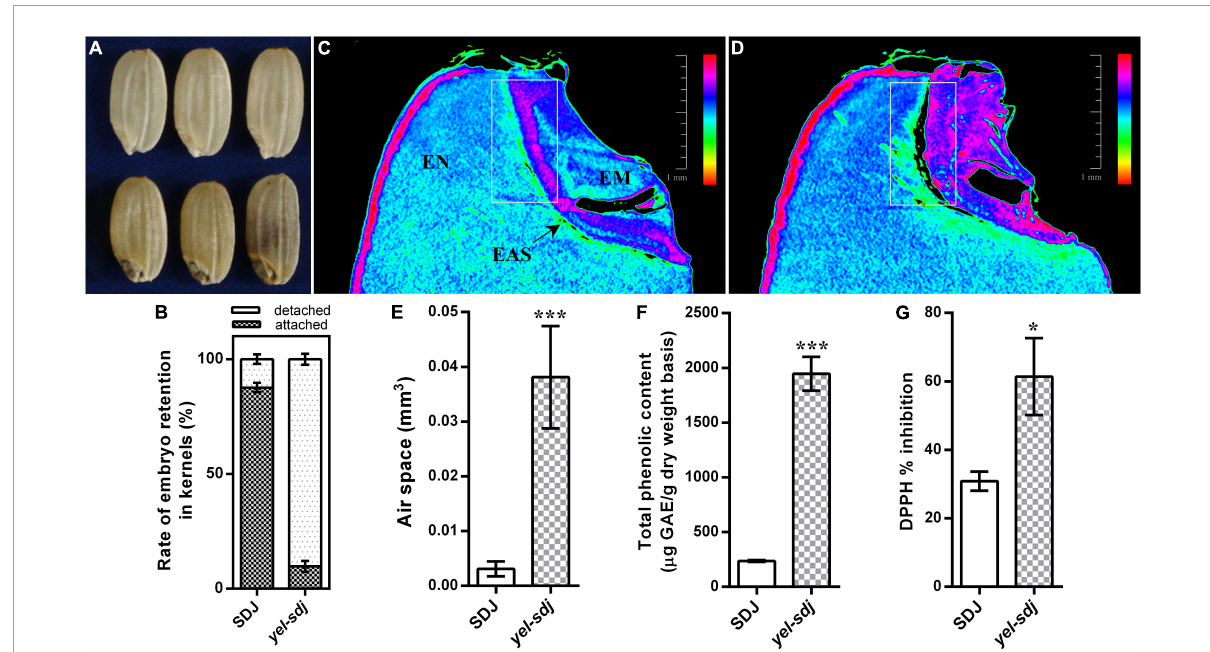
FIGURE1 Comparison of the grain characteristics of wild-type (WT; Sindongjin [SDJ]) and yel - sdj mutant rice. (A) Evaluation of the morphology of WT (upper panel) and yel - sdj mutant (lower panel) grains. (B) Rate of embryo retention in kernels after milling for 5 s. Data represent the mean ± standard deviation (SD) of five biological replicates. (C,D) Longitudinal cross section of WT (C) and yel - sdj mutant (D) grains using computed tomography (CT). White rectangles indicate the area coinciding with the air space found between the embryo and endosperm (scale bar = 1 mm). The color scale represents embryo density. EN, endosperm; EM, embryo; EAS, endosperm adjacent to the scutellum. (E–G) Volume of air space between the embryo and endosperm (E) , content of total phenolics (F) , and antioxidant activity (G) in WT and yel - sdj mutant grains. Data represent the mean ± SD of three biological replicates. Asterisks indicate statistical significance, as determined by Student’s t -test (* p < 0.05, *** p < 0.001).